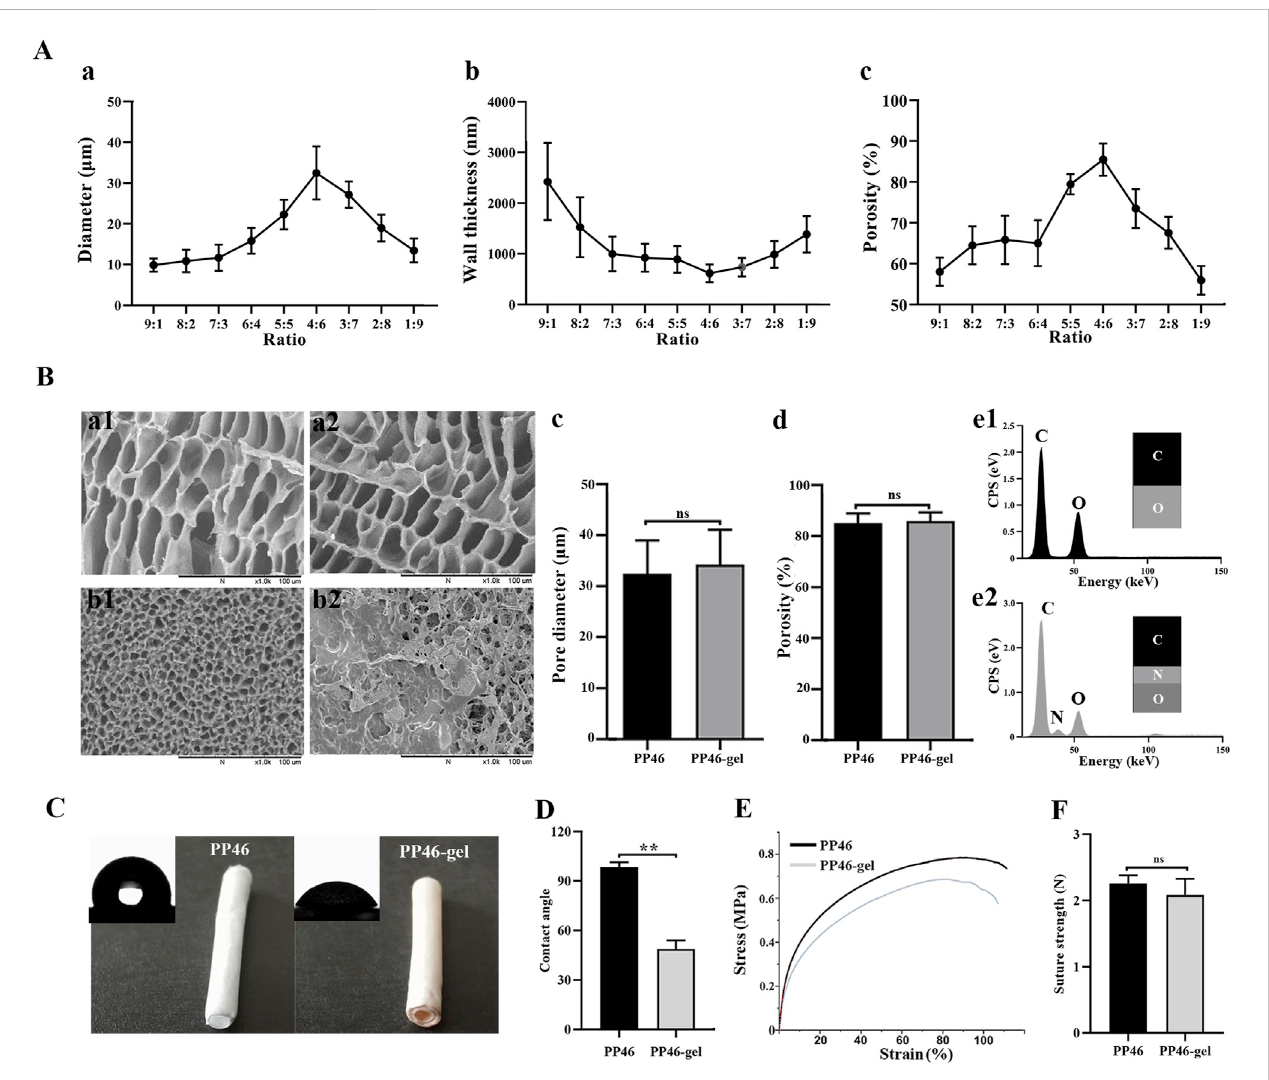
FIGURE 2 Characteristics of the PP46 and PP46-gel scaffold. (A) Pore diameter, wall thickness, and porosity as a function of the ratio of PLLA:PLCL. (B) Characteristics of the PP46 and PP46-gel. The morphology of scaffold PP46 and PP46-gel observed under SEM, cross section (a1-a2), and inner surface (b1- b2); (C, D) pore diameter and porosity of PP46-gel with scaffold PP46 as the reference (e1-e2). The EDS analysis of the inner surfaces of the PP46 and PP46- gel. (C) Contactanglealterationbeforeandaftergelatingrafting. (D) Quantitativeanalysis ofthecontactangles. (E) Stress – straincurves atadeformation rate of 10 mm/min. (F) Suture strength analysis. Data are presented as mean ± SD (** p < 0.01; ns: p >